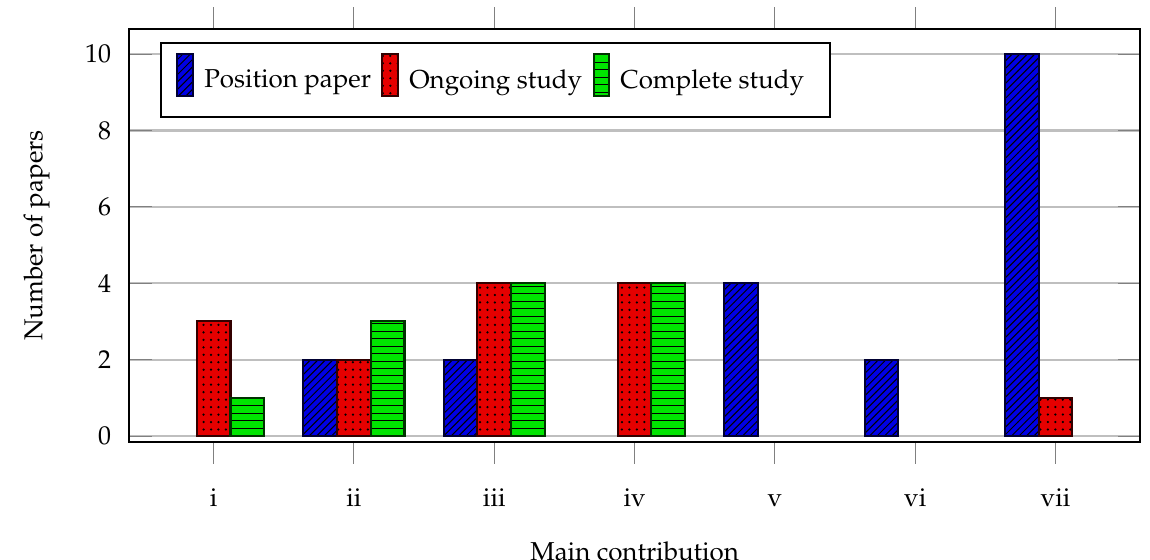
Figure 2. Research validation maturity. The contribution types are as follows; i = architecture; ii = framework; iii = architecture description language; iv = model; v = ontology; taxonomy, or controlled vocabulary; vi = secondary/tertiary study; vii =